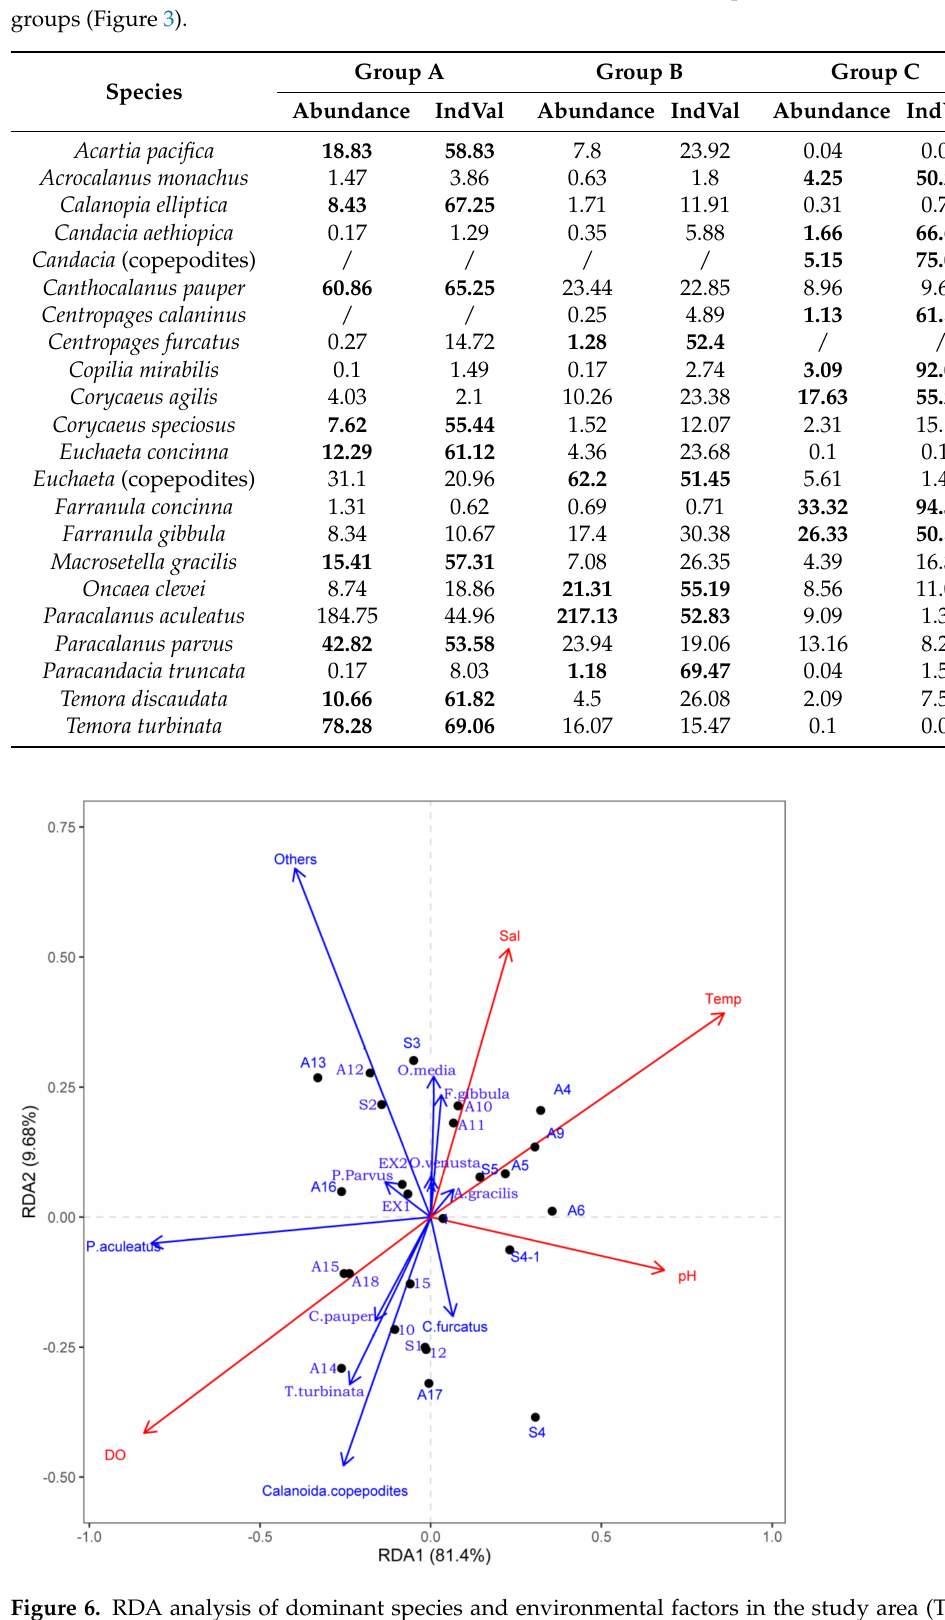
Figure 6. RDA analysis of dominant species and environmental factors in the study area (Temp: temperature; Sal: salinity; DO: dissolved